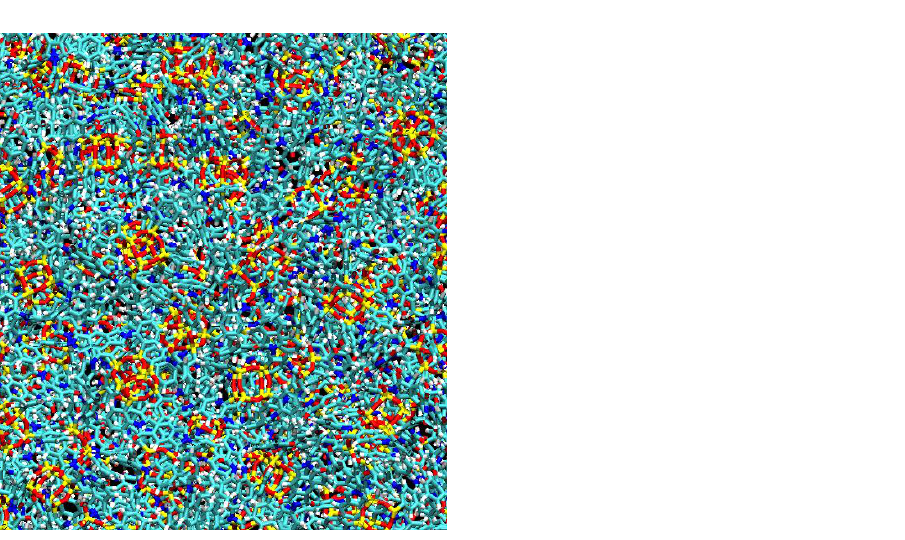
Figure 3. Schematic representation of a (60 Å ) 2 subset of the poly ortho OAPS-PMDA network at 400 °C (color code: yellow = Si, red = O, cyan = C, blue = N, green = F; white = H).